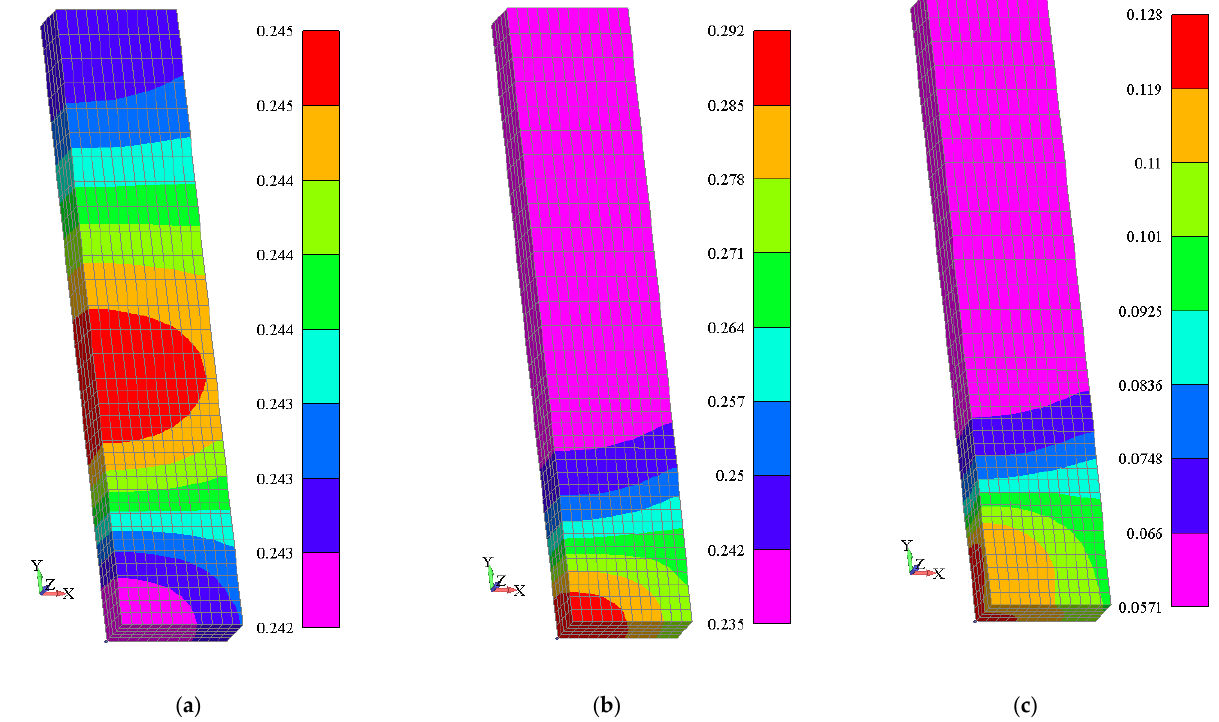
Figure 13. FEM simulation results: ( a ) Effective plastic strain field—plasticity; ( b ) Effective plastic strain field—phase-field and plasticity; and ( c ) damage field—phase-field and plasticity.